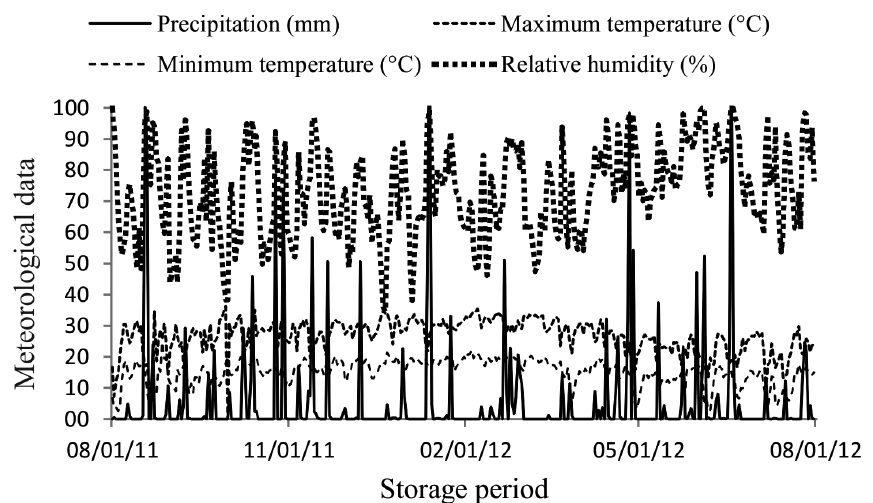
Figure 1 - Daily precipitation data (mm), relative humidity (%) and maximum and